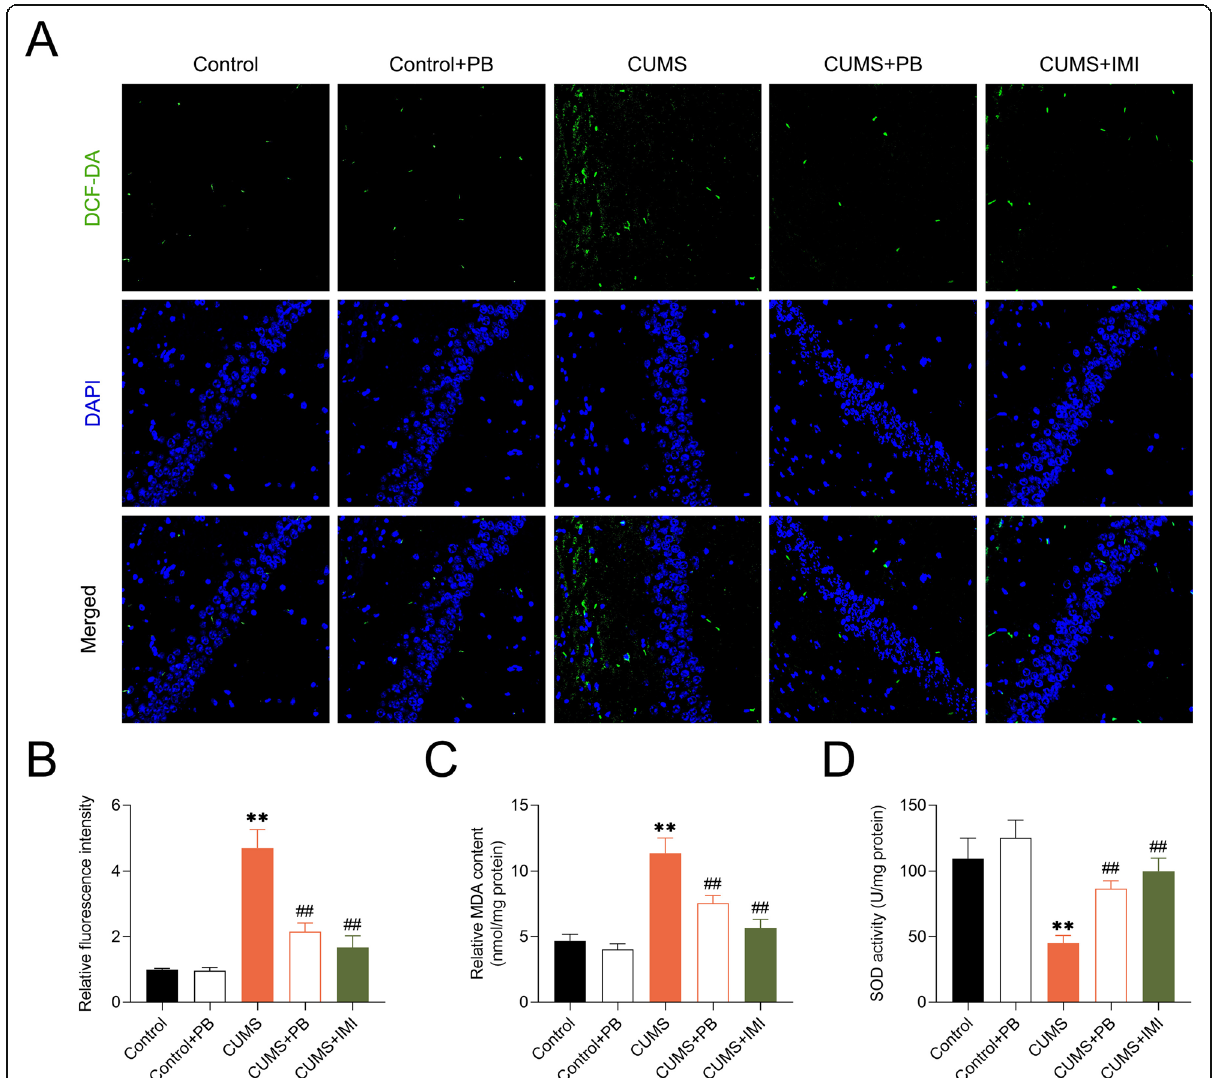
Fig. 3 PB protected against oxidative stress in hippocampus of CUMS mice a PB inhibited ROS production, which was measured using the DCFH- DA fluorescent probe under a fluorescence microscope at a magnification of × 400. b The fluorescence intensity was calculated and was correlated with the ROS level. c The concentration of MDA was measured, suggesting that PB decreased MDA concentration in CUMS mice. d The activity of SOD was measured, indicating that PB promoted SOD activity in CUMS mice. ** p < 0.01 vs. Control. ## p < 0.01 vs.